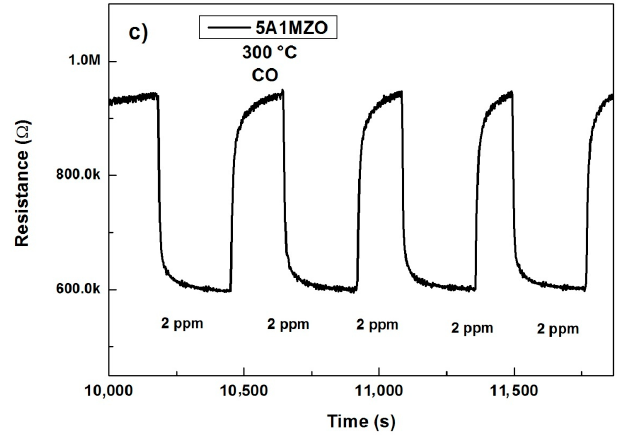
Figure 13. ( a ) Dynamic resistance change of 5A1MZO based sensor toward CO gas, ( b ) its corre- sponding calibration curve, and ( c ) its reproducibility.